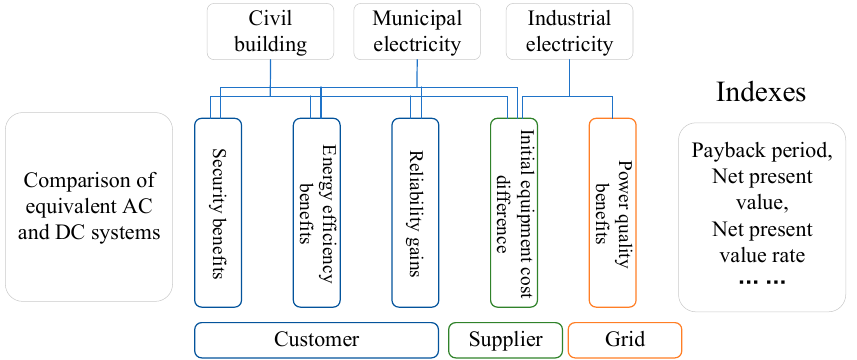
Figure 5. Economic evaluation framework of low voltage DC power distribution system.